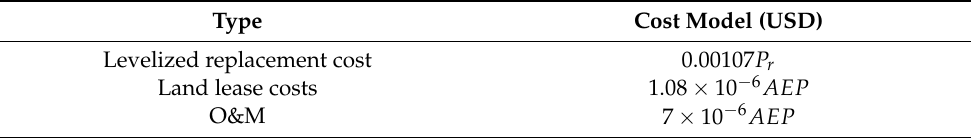
Table 4. Annual operating cost of a wind turbine [18,19].